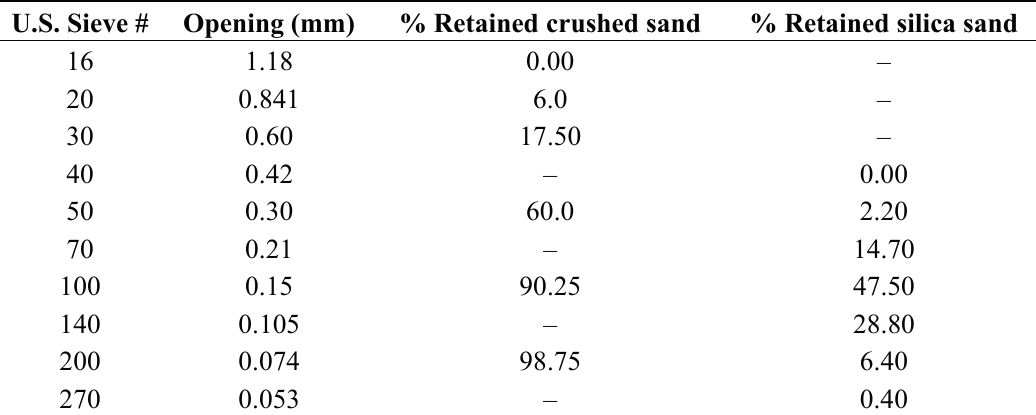
Table 2. Sieve analysis of silica sand and crushed sand.